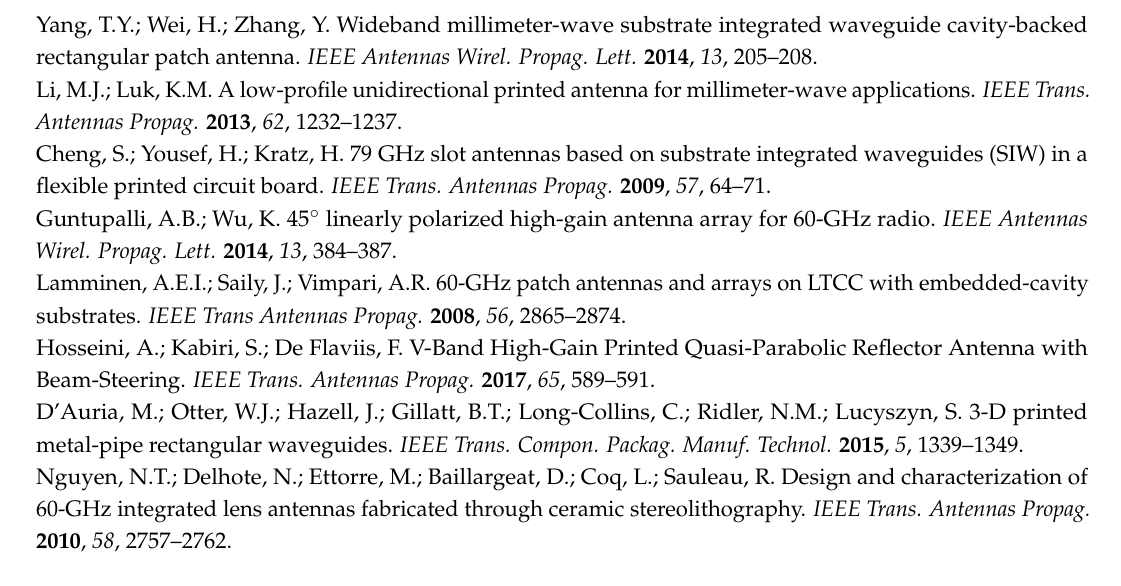
Figure 14. Simulation and test gain patterns at frequencies of ( a ) 61 and ( b ) 64